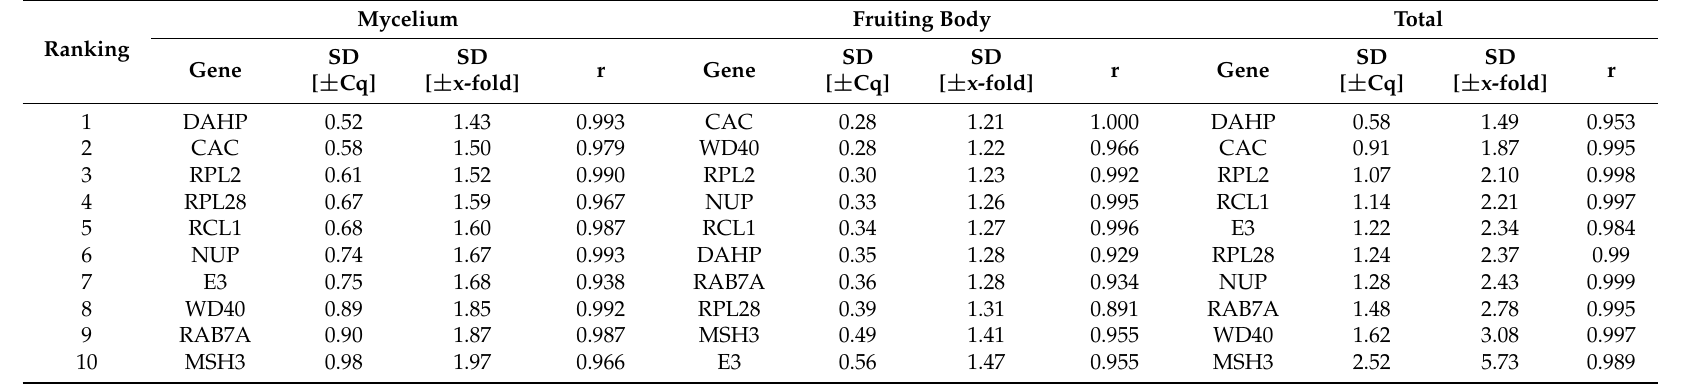
Table 3. Ranking of candidate reference genes according to